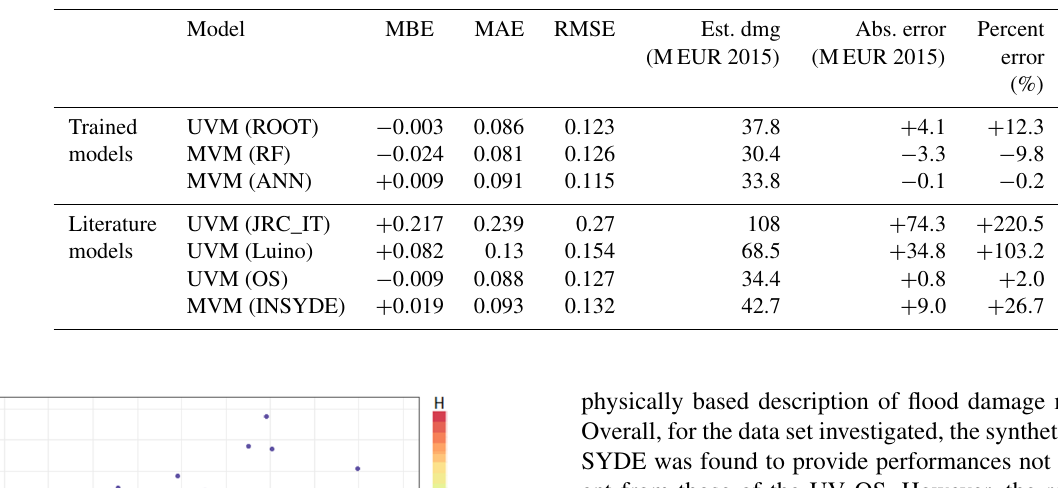
Figure 11. Comparison of the predictive capacity of UV and MV models: simulated damage ( y axis) is plotted against the observed damage ( x axis) for the UV model by using square root function (a) , random forest (b) and artificial neural network (c) . The grey dashed line shows the range of model outputs for each damage record. The median is shown in colour as a function of the record density. Table 5. Comparing error metrics between empirically based models and INSYDE.